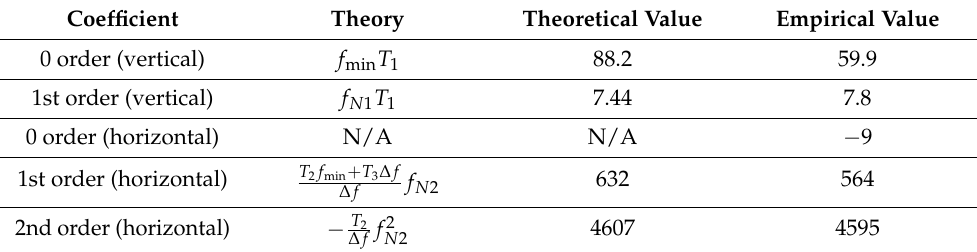
Table 1. Comparison between theoretically and empirically calculated coefficients for the phase correction functions in the vertical dimension (linear phase correction function) and in the horizontal dimension (quadratic phase correction function). The theoretical values are obtained from equation 28 of ref. [28], ignoring image charge effect, and ref [38]. Here, f min is the lowest frequency in the excitation pulse and ∆ f the frequency range in the excitation pulse, T 1 is the duration of the first encoding pulse, T 2 the duration of the third excitation pulse and T 3 is the delay between excitation and detection, f N1 is the Nyquist frequency in the vertical precursor ion dimension and f N2 is the Nyquist frequency in the horizontal fragment ion dimension (see Scheme 1).Zero order coefficients are expressed in degrees, first and second order coefficients are expressed in turns over the whole spectrum. Coefficient Theory Theoretical Value Empirical